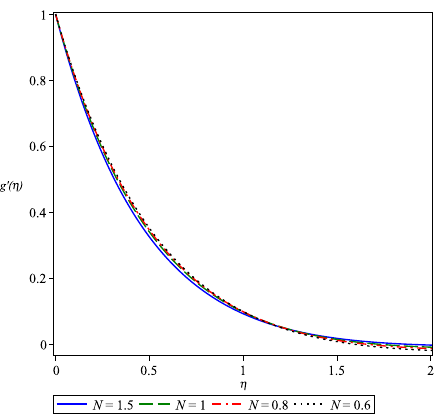
Figure 2. Dependency of velocity profile g (cid:48) on the magnetic parameter N when Sc = 0.24 and K = 0.2.